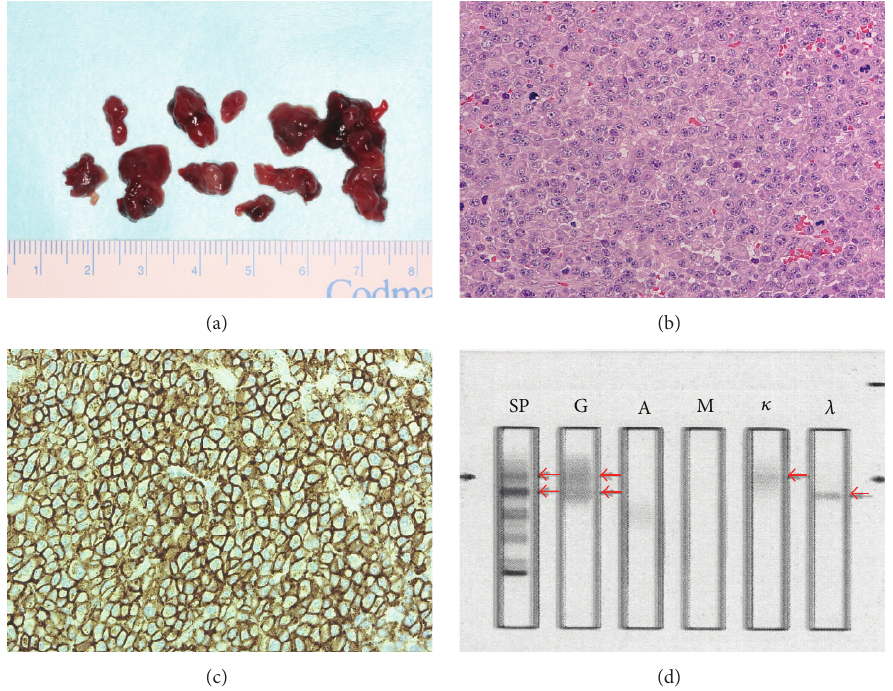
Figure 5: An incisional biopsy specimen from the maxillary lesion (a). Hematoxylin and eosin staining of the specimen shows solid proliferation of plasmacytoid cells with eccentric nuclei and basophilic cytoplasm and partially shows atypia ((b), original magnification × 40). The immunohistochemical results are positive for CD138 ((c), original magnification × 40). Serum immunofixation electrophoresis shows M-protein (IgG 𝜅 and 𝜆 types,